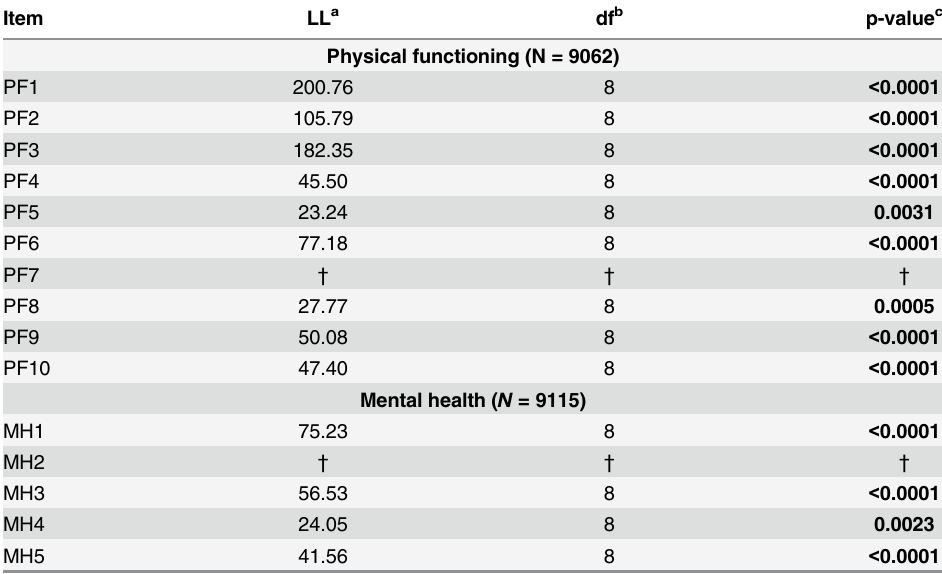
Table 2. Tests for differential item functioning on the SF-36 physical functioning and mental health sub-scale items in the Canadian Multicentre Osteoporosis Study. Item LL a df b p-value c Physical functioning (N = 9062) PF1 200.76 8 < 0.0001 PF2 105.79 8 < 0.0001 PF3 182.35 8 < 0.0001 PF4 45.50 8 < 0.0001 PF5 23.24 8 0.0031 PF6 77.18 8 < 0.0001 PF7 † † † PF8 27.77 8 0.0005 PF9 50.08 8 < 0.0001 PF10 47.40 8 < 0.0001 Mental health ( N = 9115) MH1 75.23 8 < 0.0001 MH2 † † † MH3 56.53 8 < 0.0001 MH4 24.05 8 0.0023 MH5 41.56 8 < 0.0001 a LL = log of the likelihood function. b df = degrees of freedom. LL values and df were computed as the difference between the unconstrained DIF model (i.e., including DIF effects for all items except the anchor item) and the constrained DIF model (i.e., excluding DIF effects for one item at a time). c All p-values are statistically signi fi cant using a Bonferroni-corrected α = .05/9 = .0056 for the physical functioning sub-scale items and α = .05/4 = .0125 for the mental health sub-scale items. † = anchor